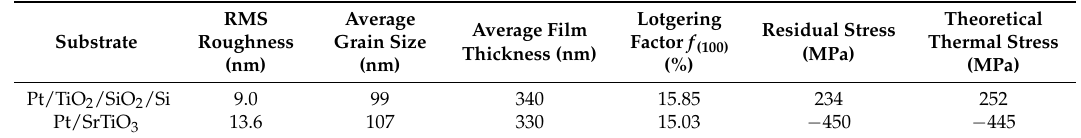
Figure 2. Topography of KNN thin films deposited on Pt/SiO 2 /TiO 2 /Si ( a ) and Pt/SrTiO 3 ( b ) substrates. Table 2. Film root mean square (RMS) roughness, average thickness, grain size, Lotgering factor, residual stress, and theoretical thermal stress for KNN films deposited on platinized Si and SrTiO 3 substrates.